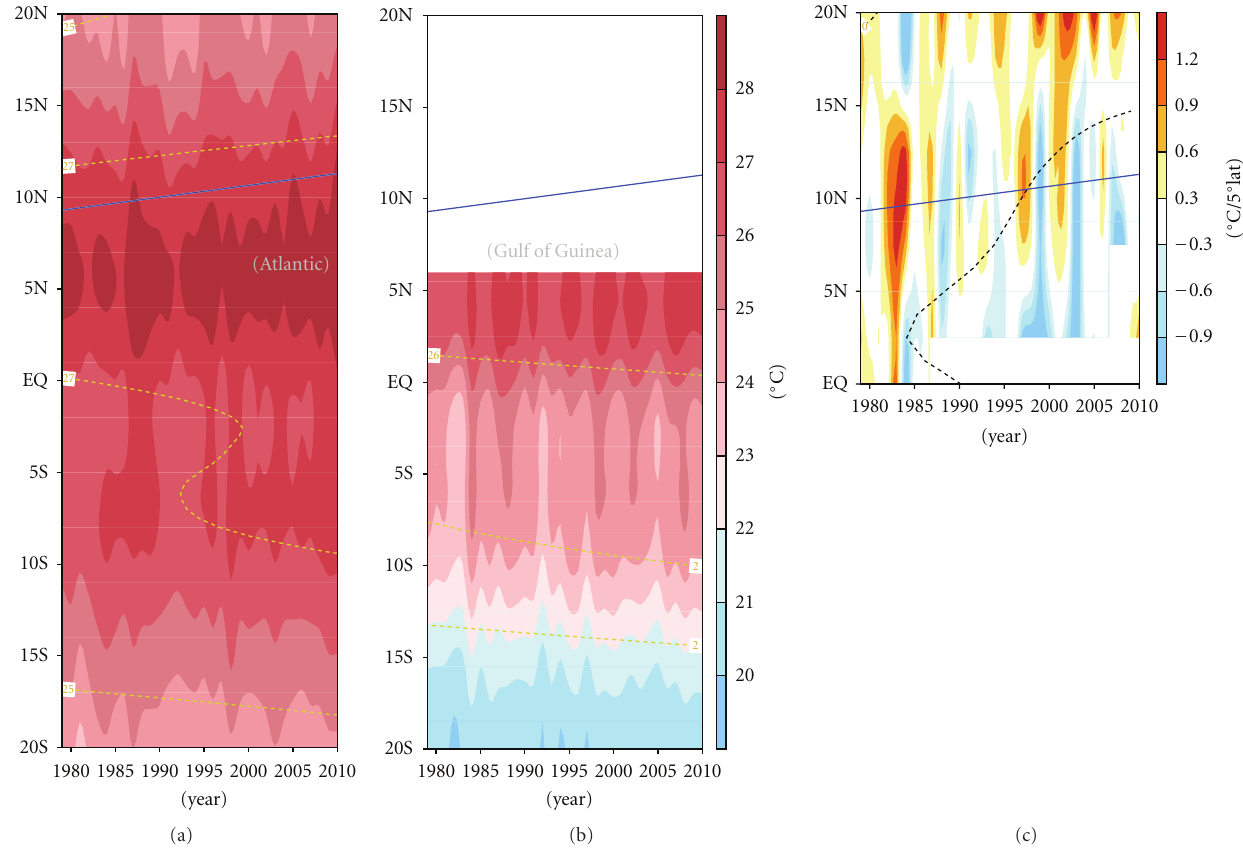
Figure 7: Evolution of SSTs over (a) Atlantic 40 ◦ W–20 ◦ W and (b) Gulf of Guinea 10 ◦ W–10 ◦ E superimposed with the linear trends (yellow dashed lines) and the Sahel rainband (thick blue line). (c) Evolution of the meridional gradient of CRU surface temperature anomalies over the central Sahel 10 ◦ W–10 ◦